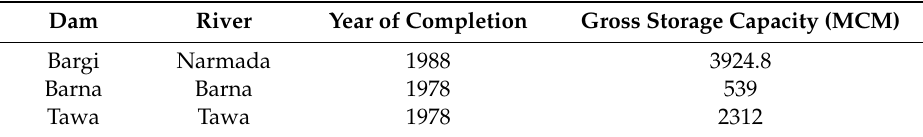
Table 2. Reservoirs included in the Upper Narmada application [38].